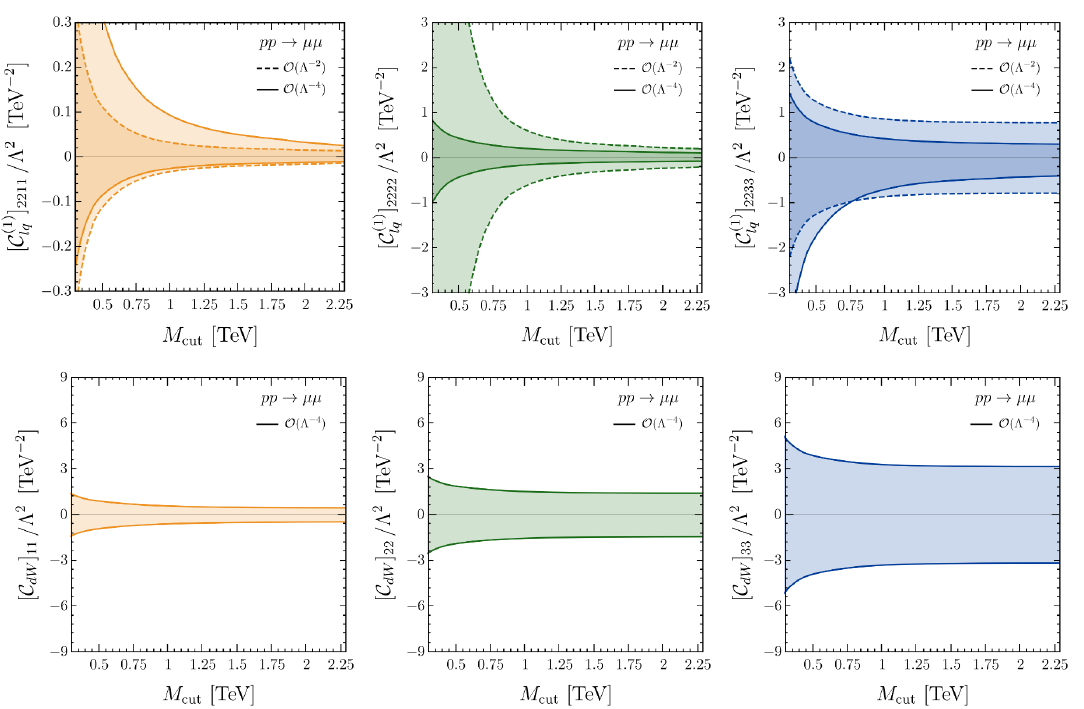
Figure 7. Clipped expected limits from LHC dimuon searches for flavor conserving operators O (1) and O as a function of the sliding maximal scale M dW to the EFT truncation at O (1 / Λ 2 ) and O (1 / Λ 4 ) ,